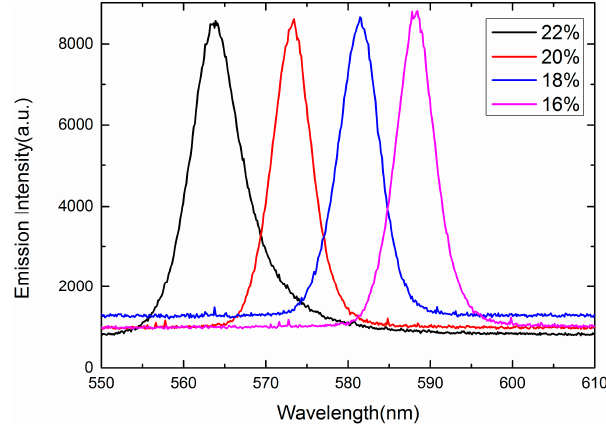
Figure 7. Measured emission spectra of templated SPLC systems with different concentrations of the polymer.